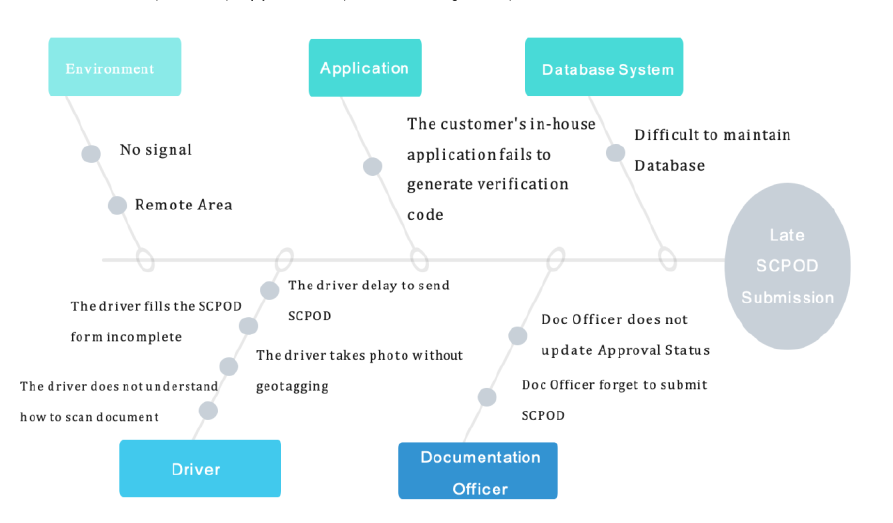
Figure 5: Cause-and-Effect Diagram (edited using